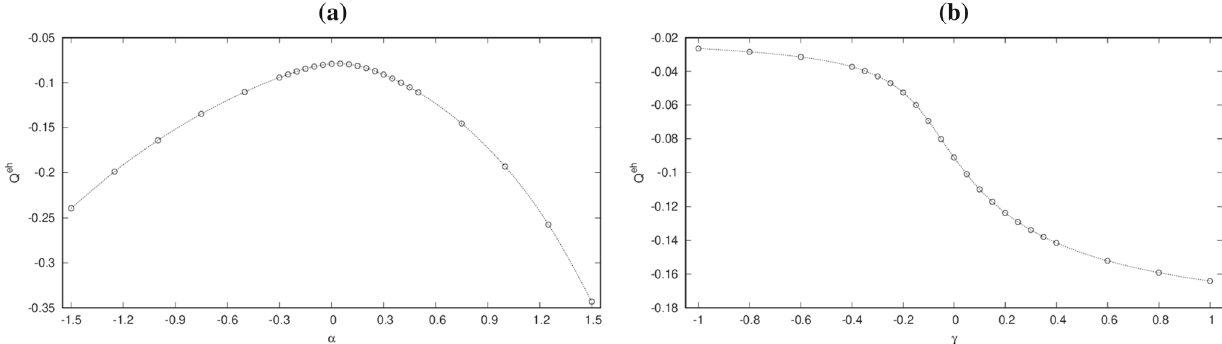
Fig. 6 The u -locations of the event horizons, u eh , radii, r eh , and masses, m eh of a α and b γ . The non-varying parameters were α = − 1 for ( b ), γ = 1 for ( a ) and ˜ p s = ˜ p h = 0 . 04